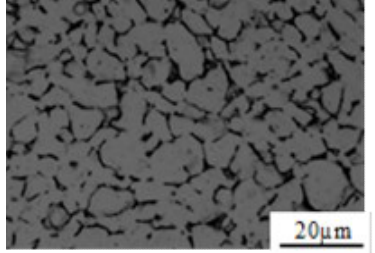
Figure 2. Optical micrograph of Ti–6Al–4V prior to deformation.